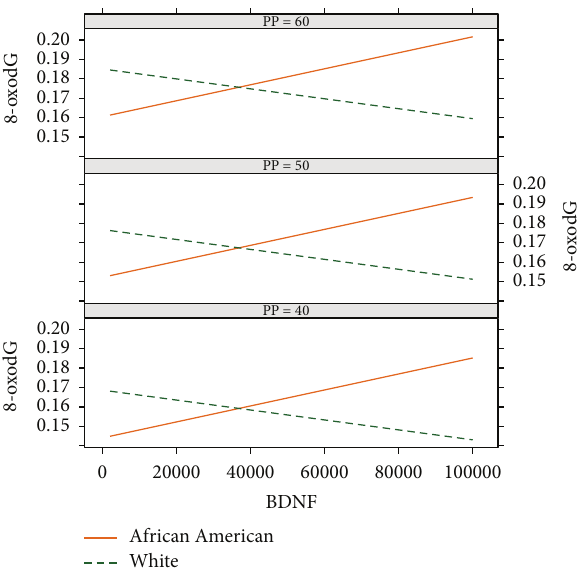
Figure 1: Association of 8-oxodG on BDNF at selected levels of hsCRP in African Americans (AA) and whites. For the graphs, each box corresponds to different levels of hsCRP. BDNF levels are indicated on the 𝑥 -axis and 8-oxodG levels are shown on the 𝑦 -axis. At low levels of hsCRP, 8-oxodG levels are identical between AAs and whites at all levels of BDNF. However, with increasing levels of hsCRP and at high levels of BDNF, white women have elevated levels of 8-oxodG compared with AA women.